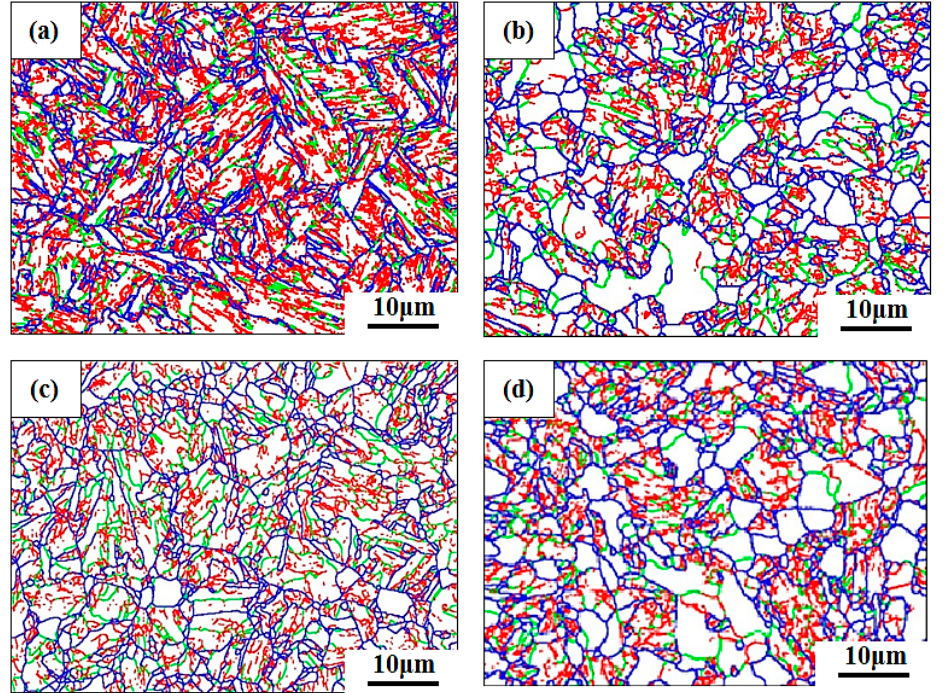
Figure 7. Grain boundary maps of the ( a ) 1060NT-OT, ( b ) 1060NT-PT, ( c ) 940NT-OT and ( d ) 940NT-PT samples.